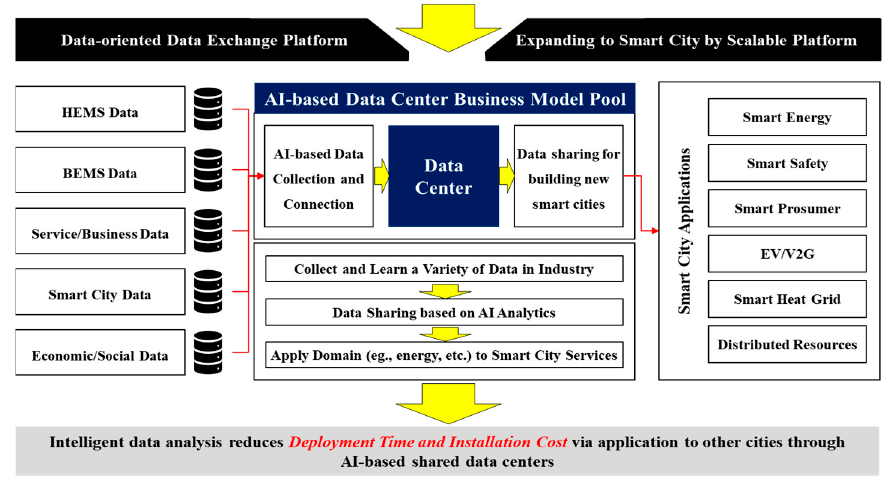
Figure 17. Business Model (BM) and Derivative Gains of the Proposed System.